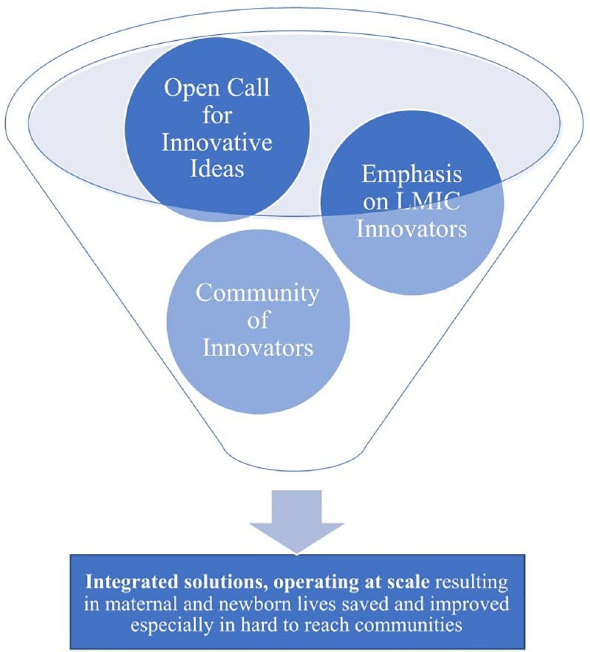
Fig 1. Key components of the SL@B theory of change based on Lalli, et al. (2018).